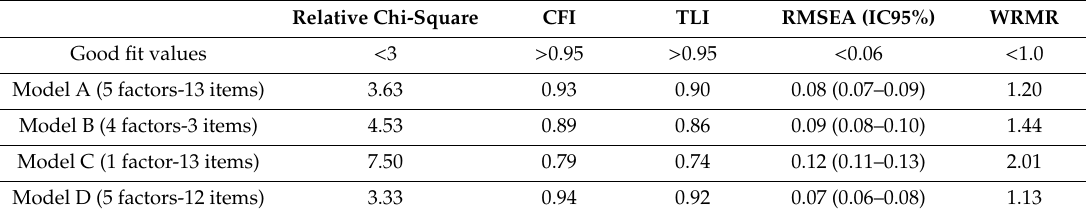
Table 5. Confirmatory factor analysis of several models of the APuP questionnaire (Spanish version). Relative